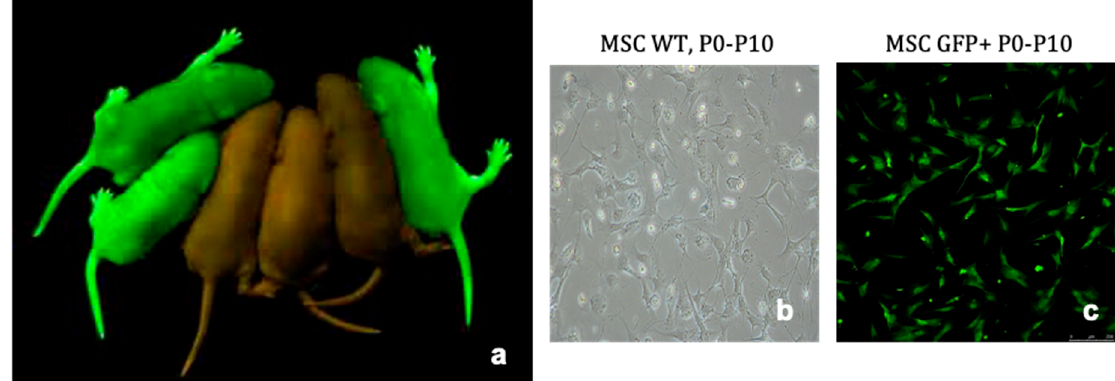
Figure A1. Wystar Kyoto wildtype (WKY-wt) and transgenic WKY rats positive for green fluorescent protein (WKY-GFP) ( a ) were used as bone marrow donors for the extraction of wildtype MSCs ( b ) and GFP+ MSCs ( c ). Pictures of cells were taken using light microscopy at a 20× magnification for wildtype cells of all donors and for all passages. In ( b ) one representative picture of WKY-wt cells in culture, at a 20× magnification, from a young donor in passage 5 is shown. Using a confocal microscope to detect the green fluorescence in GFP+ cells, in ( c ), a representative picture of WKY-GFP cells in culture, at a 20× magnification, is shown. Cells were in passage 5 and from a young donor rat (6 weeks of age). Strong green fluorescence was present throughout all passages ( c ). Microscopic features were similar for both age groups and throughout passages.